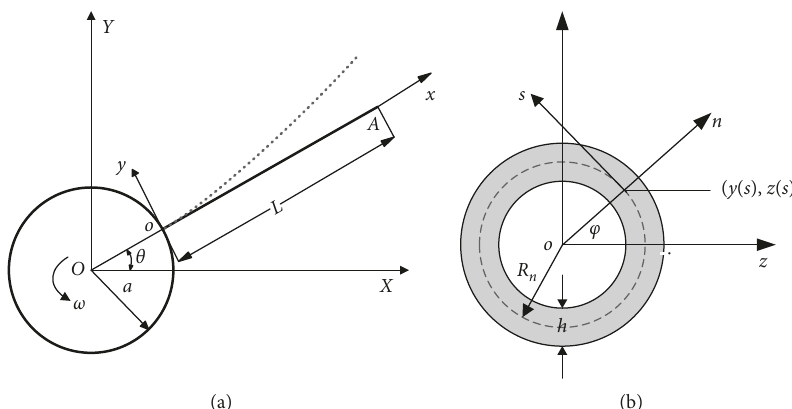
Figure 1: Dynamic model of fractional derivative viscoelastic rotating hollow beam. (a) Fractional derivative viscoelastic rotating hollow beam. (b) Viscoelastic rotating hollow beam profile.